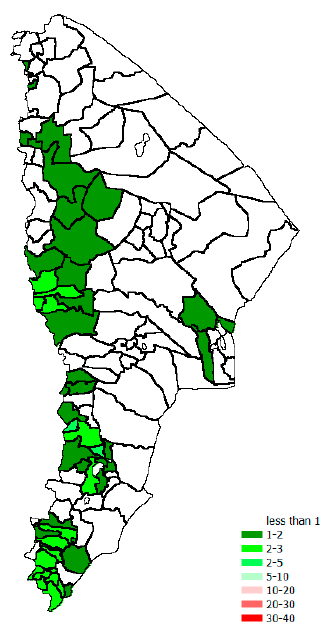
Figure 12. Ratio of livestock demand over fodder supply after migration (scale 1:7,200,000).